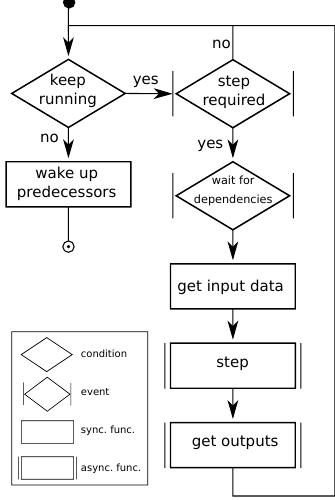
Figure 2. Simulation process for an individual